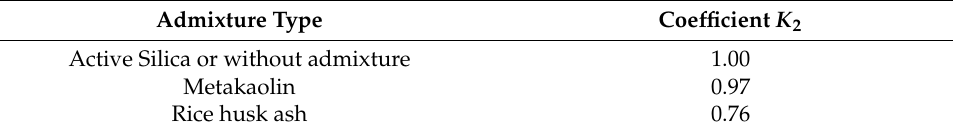
Table 4. Model coefficients as a function of the concrete admixture